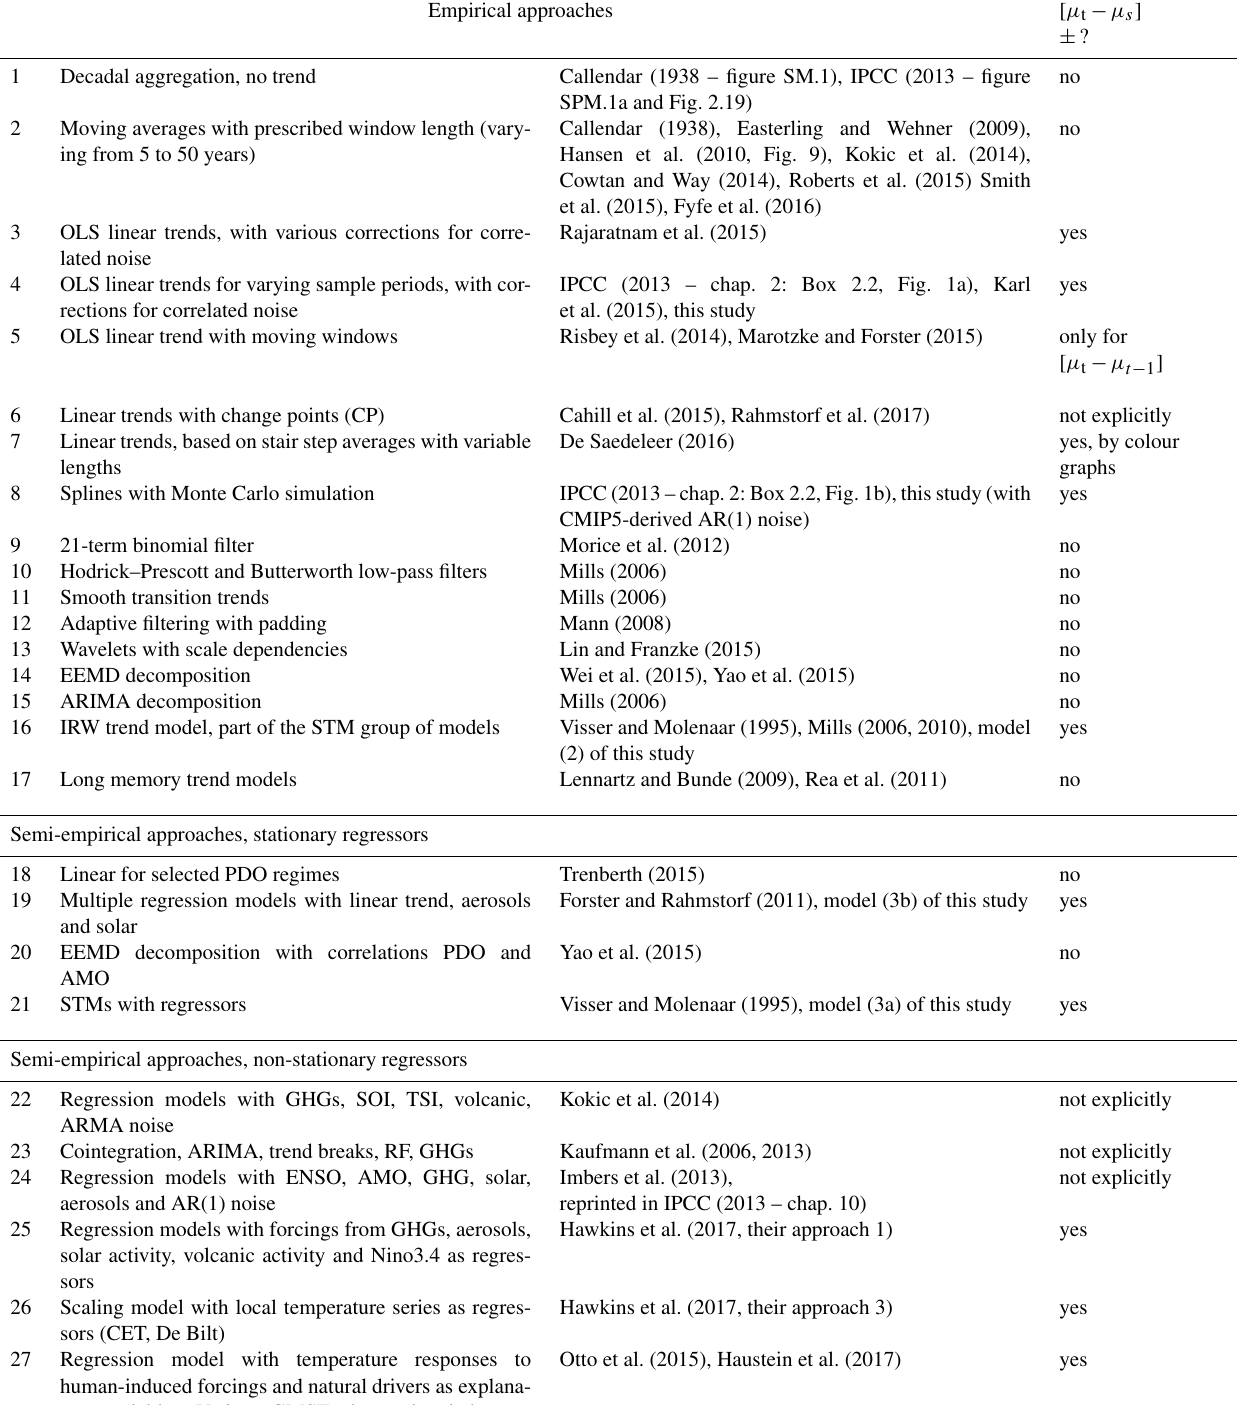
Table A1. Summary of three groups of modelling approaches to global mean temperatures: (i) empirical, (ii) semi-empirical with stationary regressors, and (iii) semi-empirical with non-stationary regressors. In the fourth column the presence of uncertainties for rates of change is given ([ µ t − µ s ] ± ?). The term “not explicitly” means that uncertainties could be calculated in principle but not shown by the